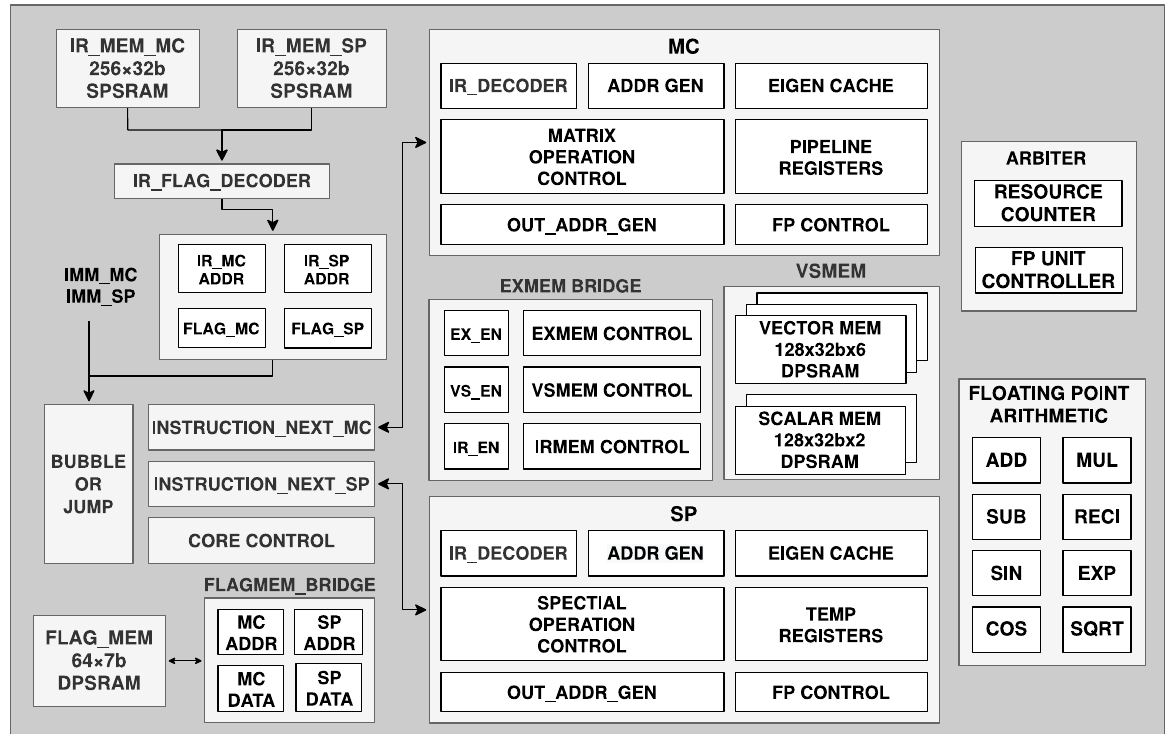
Figure 7. Modules and processing flow of the programmable computation core. Table 2. Description and time consumption of operations supported by the computation core.